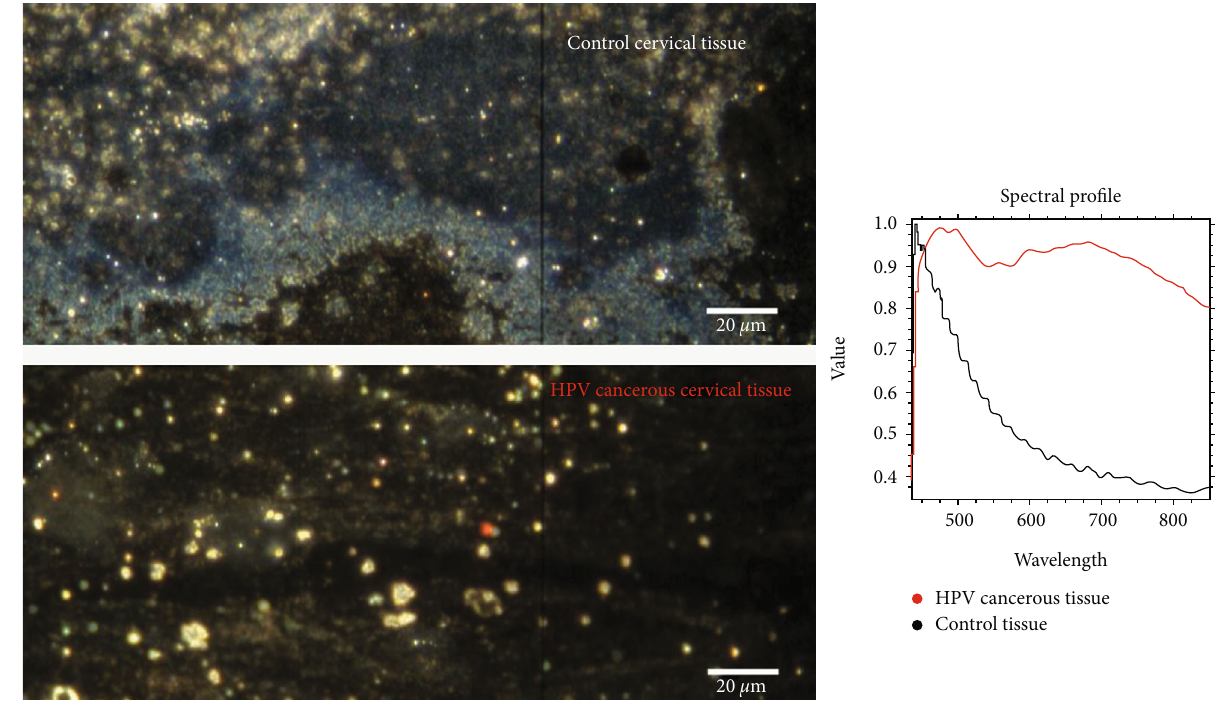
Figure 4: Enhanced dark fi eld hyperspectral microscopy-control cervical tissue versus HPV 16 cervical